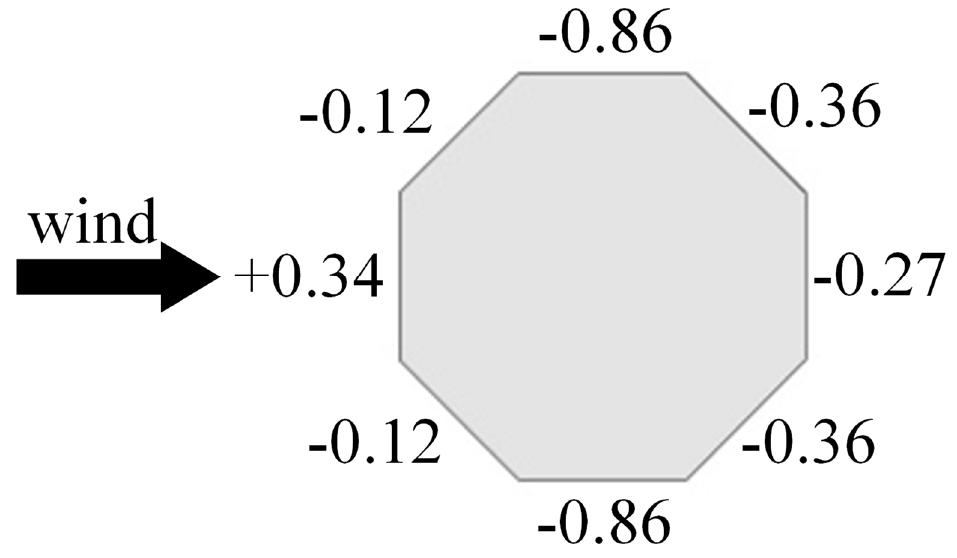
Figure 37. Reference values for the mean shape coefficients of the enclosed octagonal cross-section building with the grid structure.